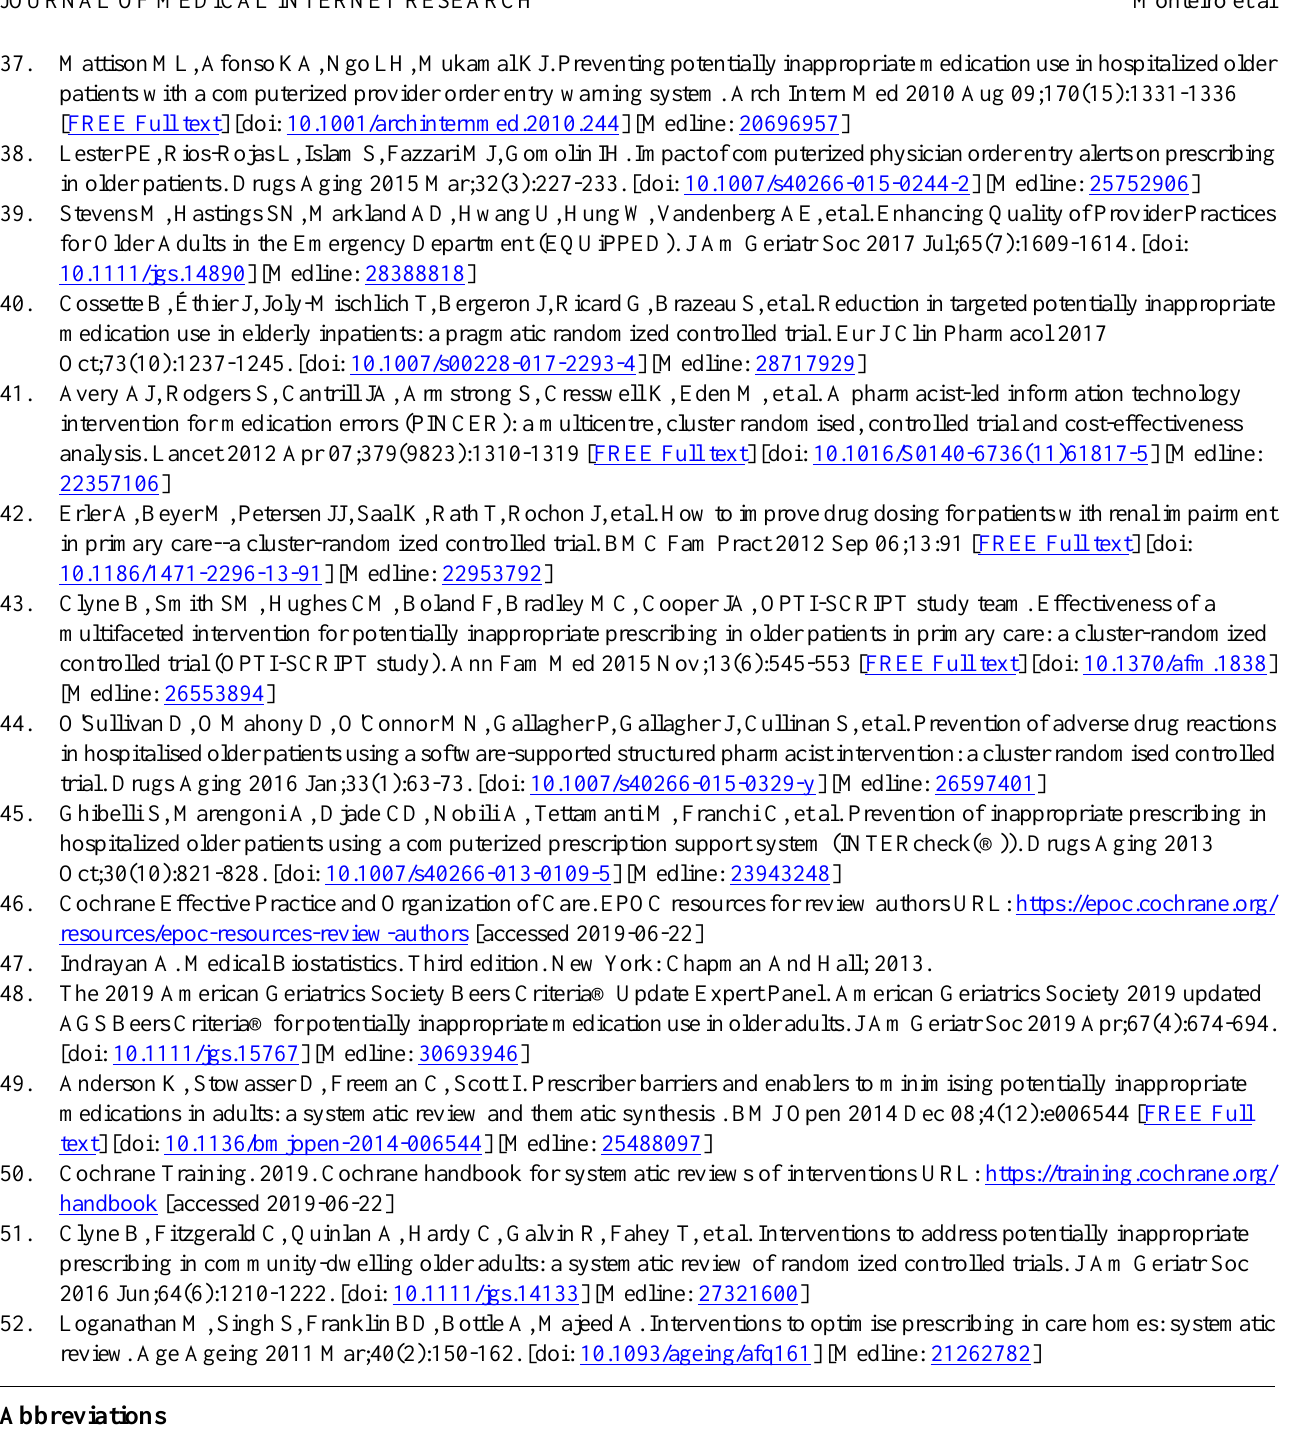
Abbreviations CDS: computerized decision support NSAID: nonsteroidal anti-inflammatory drugs PDDI: potential drug-drug interaction PIM: potentially inappropriate medications PIP: potentially inappropriate prescriptions RCT: randomized controlled